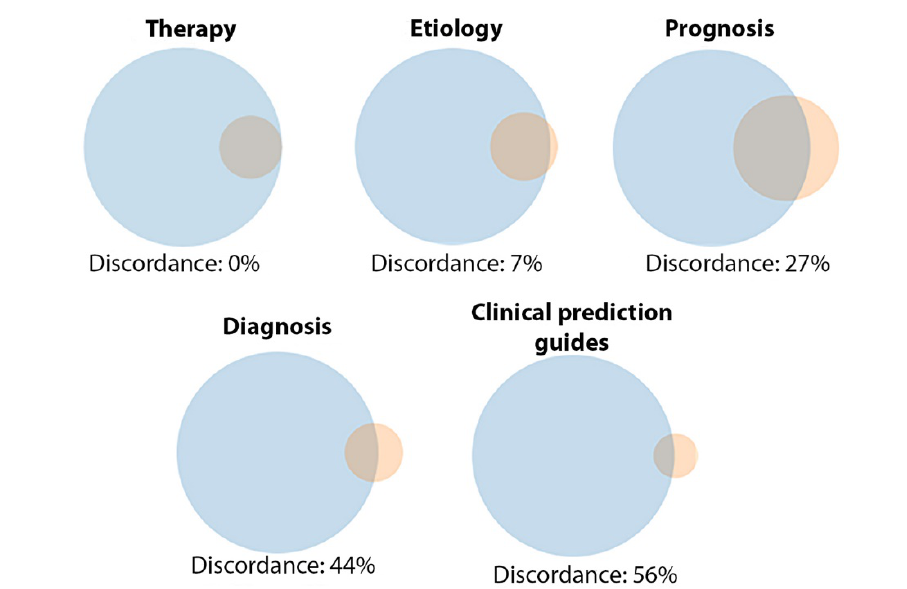
Figure 1 Discordances between Filter /Narrow and Filter /Broad for clinical study